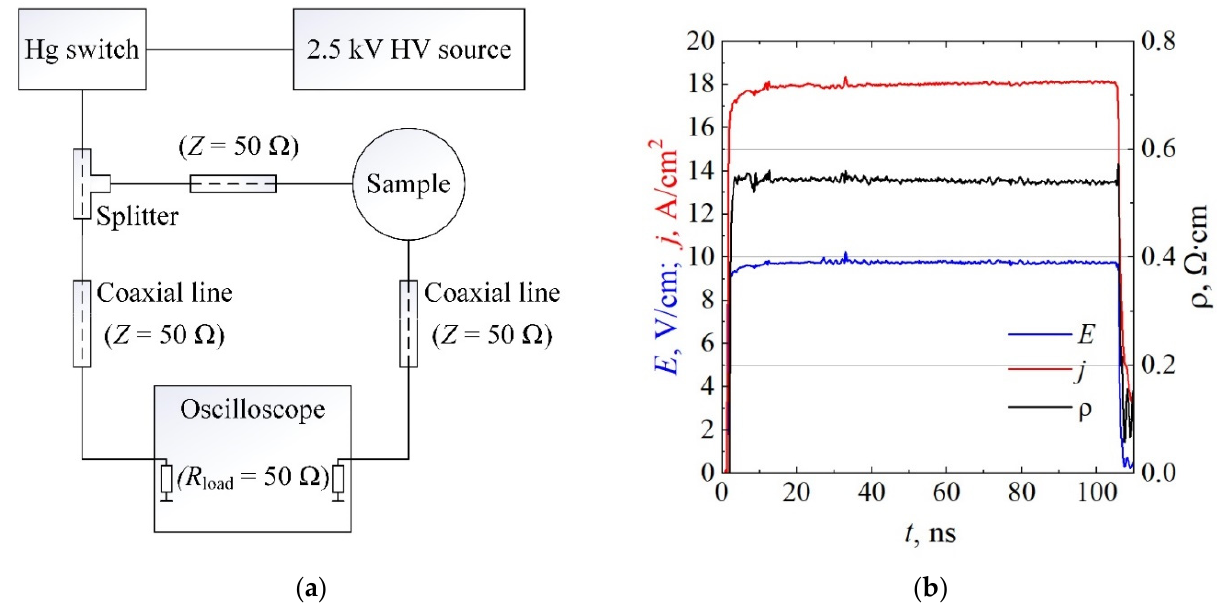
Figure 3. ( a ) Electrical scheme of I/V characteristic measurements in the regime of nanosecond duration pulses of electric field. ( b ) Example of shape of electric field, current density, and resistivity pulsed traces obtained at low electric field.